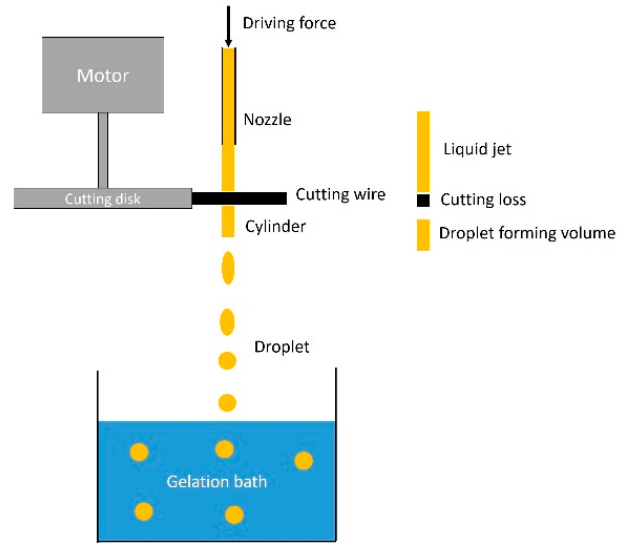
Figure 1. Schematic drawing of the jet cutting process. Table 1. Nozzle/cylinder ratios used for jet cutting of different biopolymer solutions.